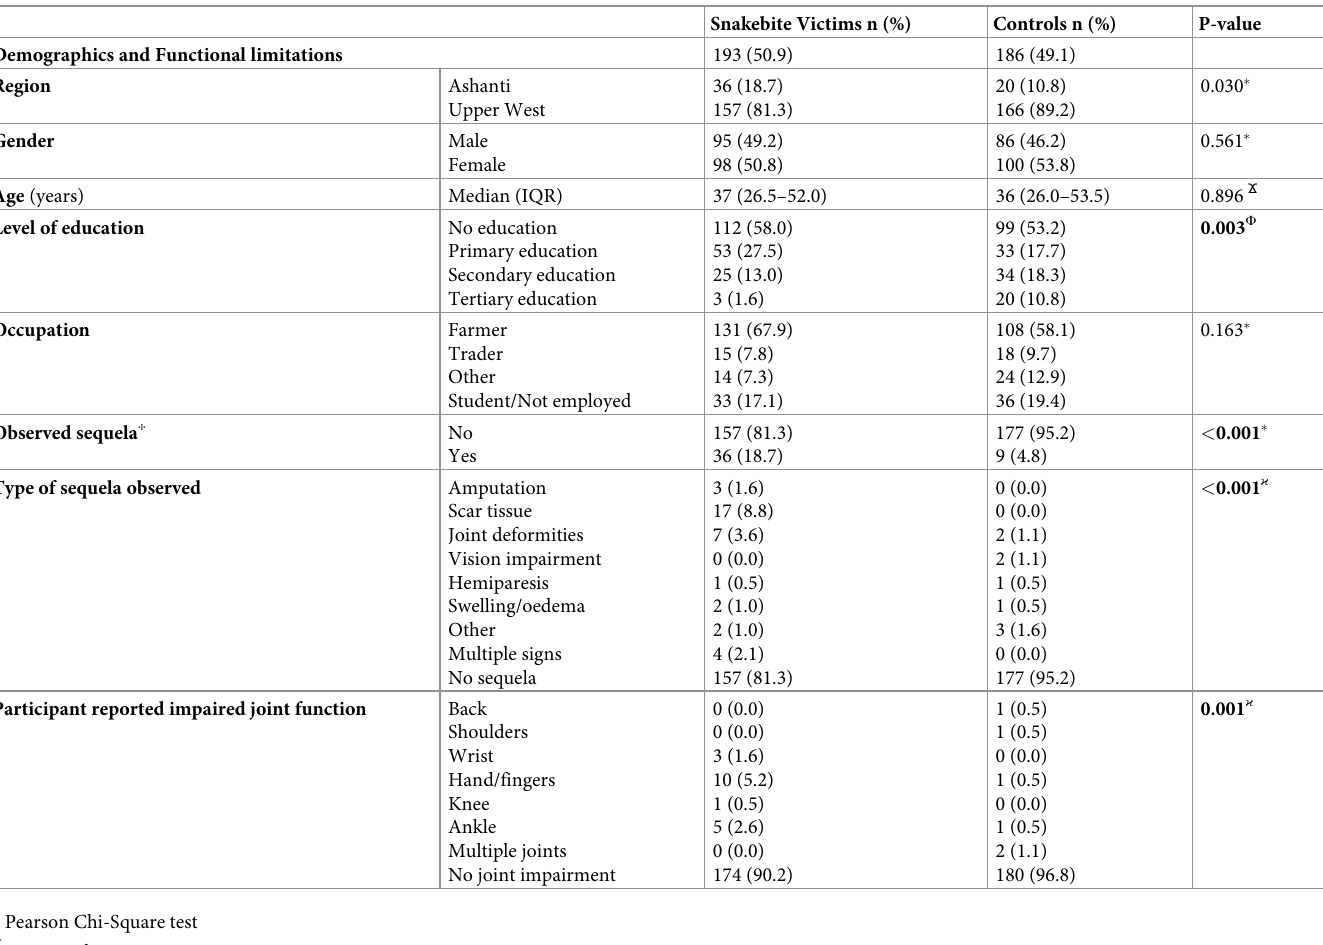
Table 1. Characteristics of the study participants ( N =